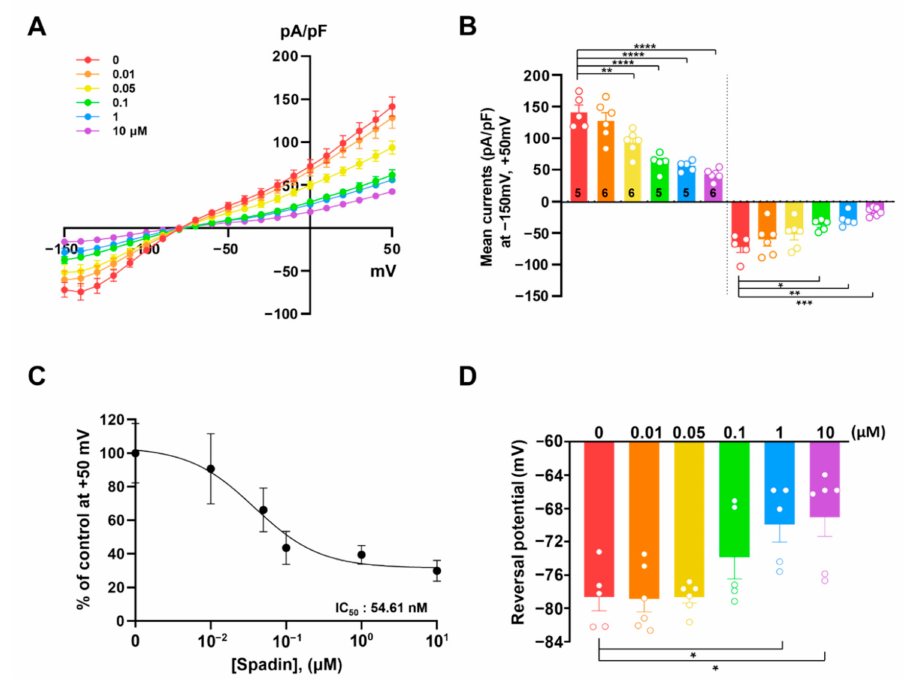
Figure 1. Spadin inhibits K + currents in cultured astrocytes in a concentration-dependent manner. ( A ) Current densities induced by voltage ramping were recorded in cultured astrocytes before and after application of spadin. Whole-cell recording showed that K + currents were inhibited by spadin in a concentration-dependent manner. ( B ) Bar graph showing K + currents averaged from results in ( A ) at + 50 mV and − 150 mV. The number on each bar indicates n for each condition. ( C ) Spadin concentration–response curves to outward currents at + 50 mV. ( D ) Reversal potential before and after spadin treatment. Data are obtained from results in ( A ). All values are mean ± standard error of the mean (s.e.m). p -values were obtained with one-way ANOVA followed by Turkey’s post hoc test. * p < 0.05, ** p < 0.01, *** p < 0.001, and **** p <